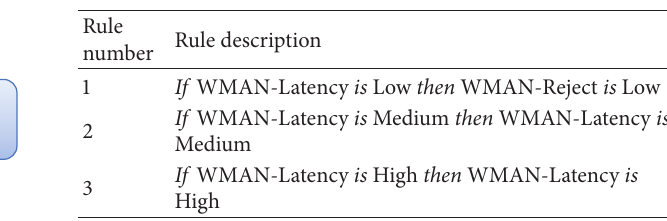
Table 4: Rule set for